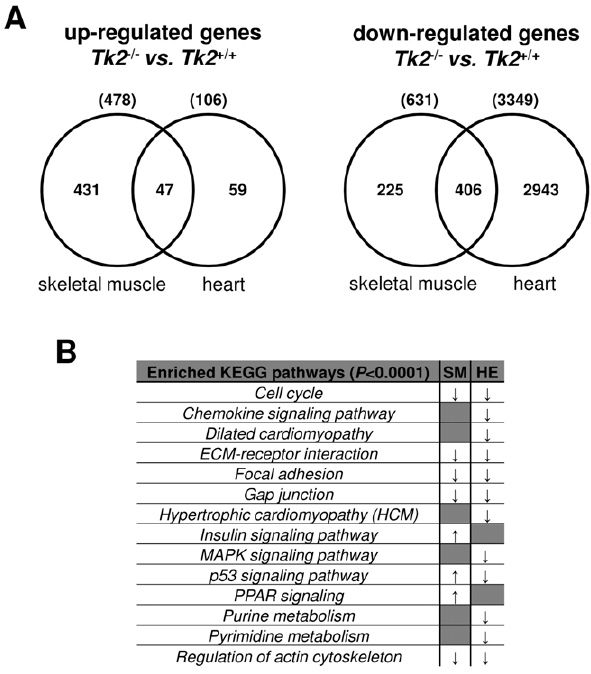
Figure 2. Gene expression deregulation in 11 days-old Tk2 knockout ( Tk2 2 / 2 ) skeletal muscle and heart comparing to wild-type ( Tk2 + / + ) tissues from mice with the same age. A ) Considering only genes with at least 2.0-fold variation in expression and with a statistically significant P -value ( P -value , 0.05), the number of up- and down-regulated genes in Tk2 2 / 2 skeletal muscle and heart, comparing to the same tissues in Tk2 + / + mice, are indicated. The numbers of similar genes that were up- or down-regulated in both analyses are indicated in the intersection of the Venn diagrams. B ) In the group of differentially expressed genes in skeletal muscle and heart, statistically significant enrichment of genes belonging to specific KEGG pathways was detected using the Pathway analysis from the Expander software (see methods). Pathways significantly enriched in the group of up-regulated genes are marked with an upwards arrow ( q ) and those enriched in the group of down-regulated genes are marked with a downwards arrow ( Q ). SM and HE indicate each of the gene expression analyses done, in skeletal muscle and in heart, respectively.